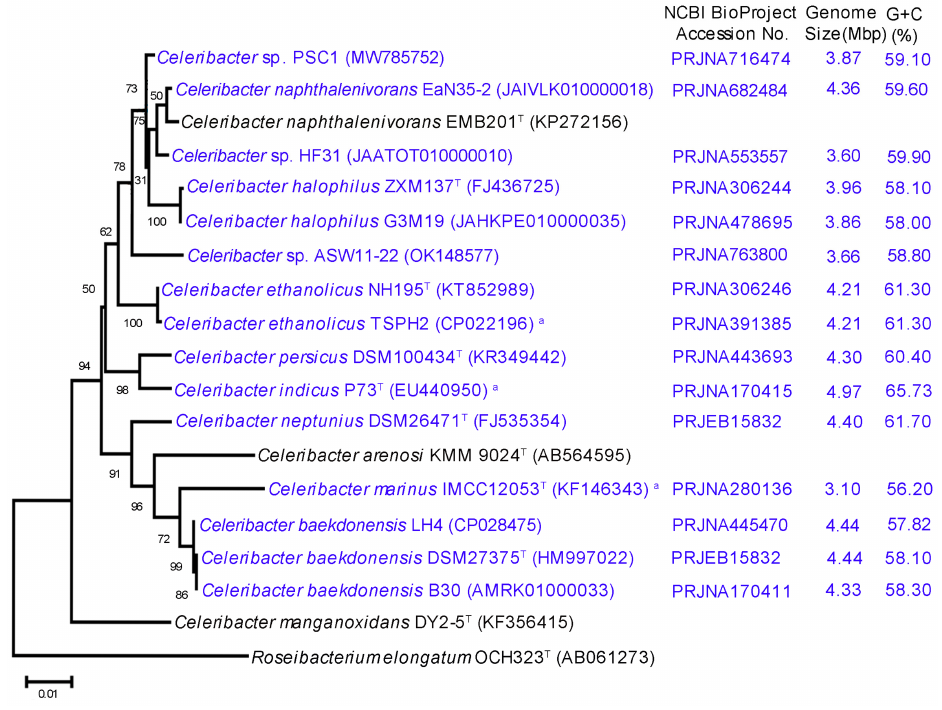
Figure 1. Phylogenetic tree based on 16S rRNA gene sequences showing the relationship between strain PS-C1 and representatives of Celeribacter spp. [19–32]. The 16S rRNA NCBI GenBank accession number for each strain is shown in brackets. The 16S rRNA sequences were aligned using ClustalW, and the tree was constructed using a neighbour-joining method with 1000 bootstrap replicates embedded in the MEGA11 software package [45]. The sequenced genomes and their respective information are indicated in blue. The scale bar represents 0.01 nucleotide substitution per site.